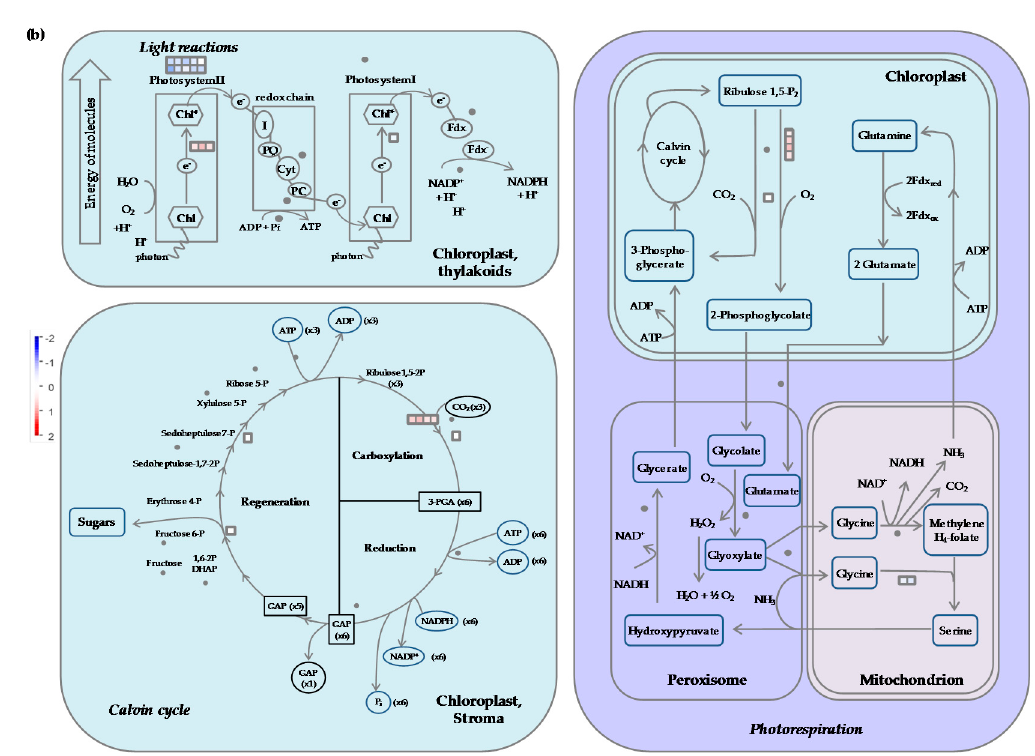
Figure 6. Visualization of the photosynthesis pathway modulation at ( a ) 8 h and ( b ) 2 h PS. At 2 h PS, the expression of genes encoding PSII cytochrome b559 (cyt b559; VIT_13s0101g00200) and NADH-plastoquinone oxidoreductase subunit K (VIT_07s0031g01060) was slightly induced (Supplementary file 8; Figures 5b and 6b). Cyt b559 is an integral component of the PSII complex [112], involved in the cyclic electron transfer around this photosystem, notably as a protective